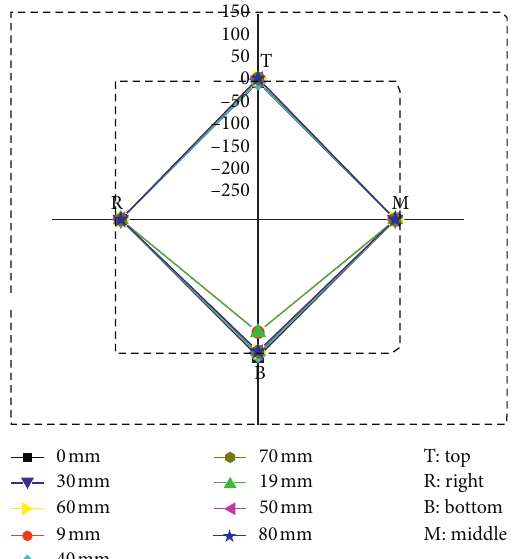
Figure 22: Footwall cross-sectional cabin 1 displacement.